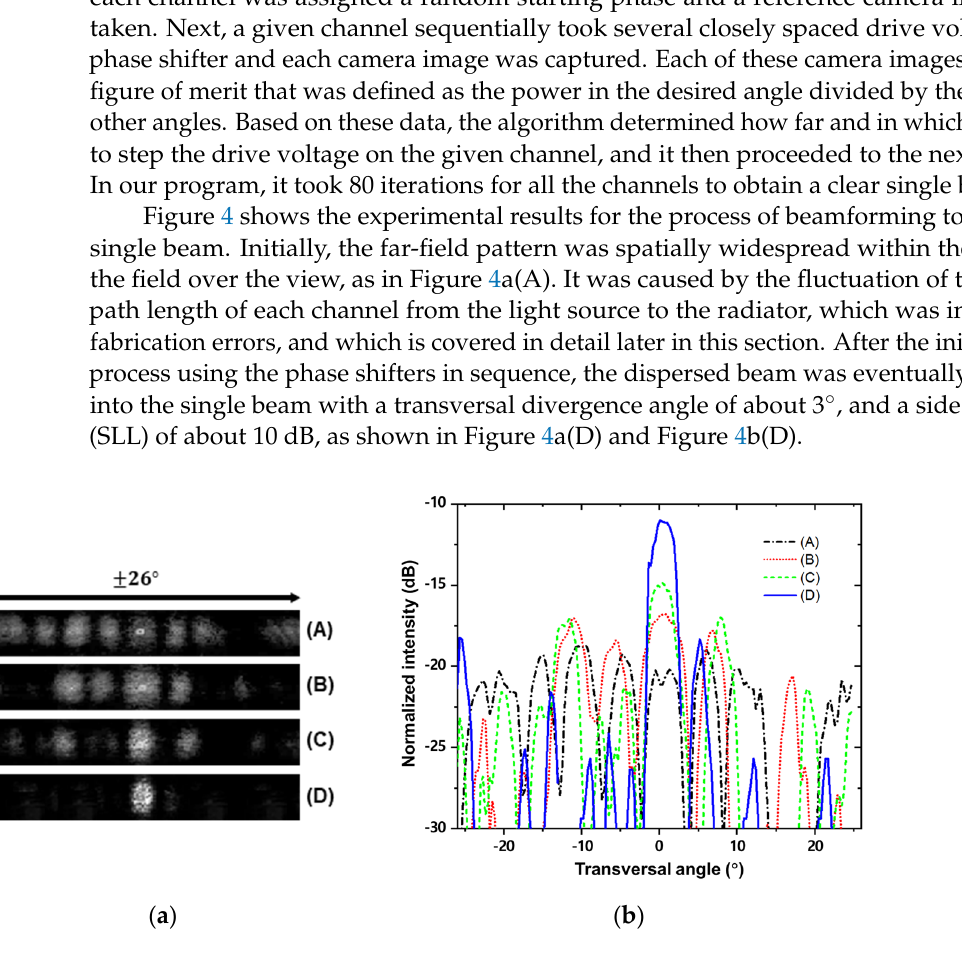
Figure 3. Calculated result of skip angle δ θ ⊥ in the longitudinal direction with variation of the path difference Δ L in the phase-feeding lines.